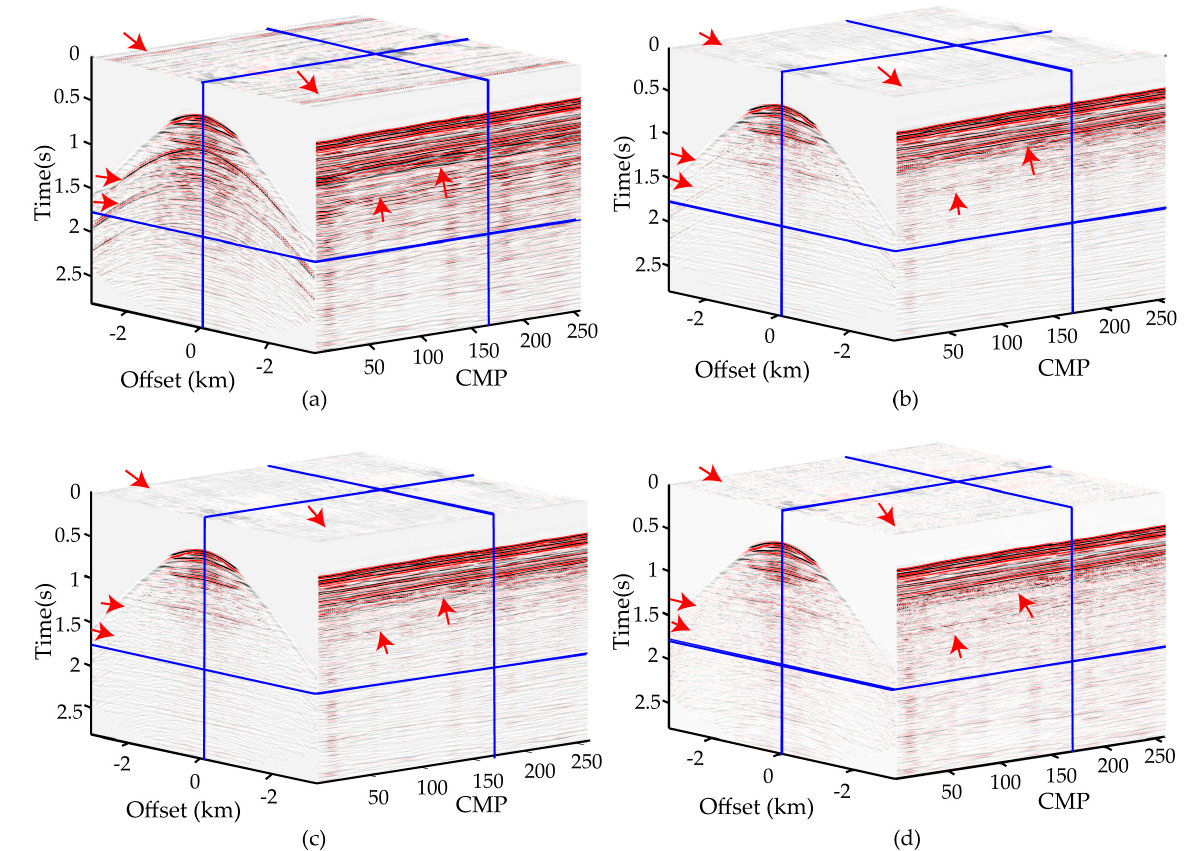
Figure 10. Multiple attenuation result: ( a ) pre-stack real data; ( b ) LSPRT method; ( c ) SPRT 𝐿 (cid:2869) − 𝐿 (cid:3044) method. The red arrows indicate the cleaner multiple attenuation in the method; ( d ) SPRT 𝐿 (cid:3044) ( d ) SPRT L q 1 − L q 2 method. The red arrows indicate the cleaner multiple attenuation in the Figure (cid:3117) (cid:3118) Figure 10d.